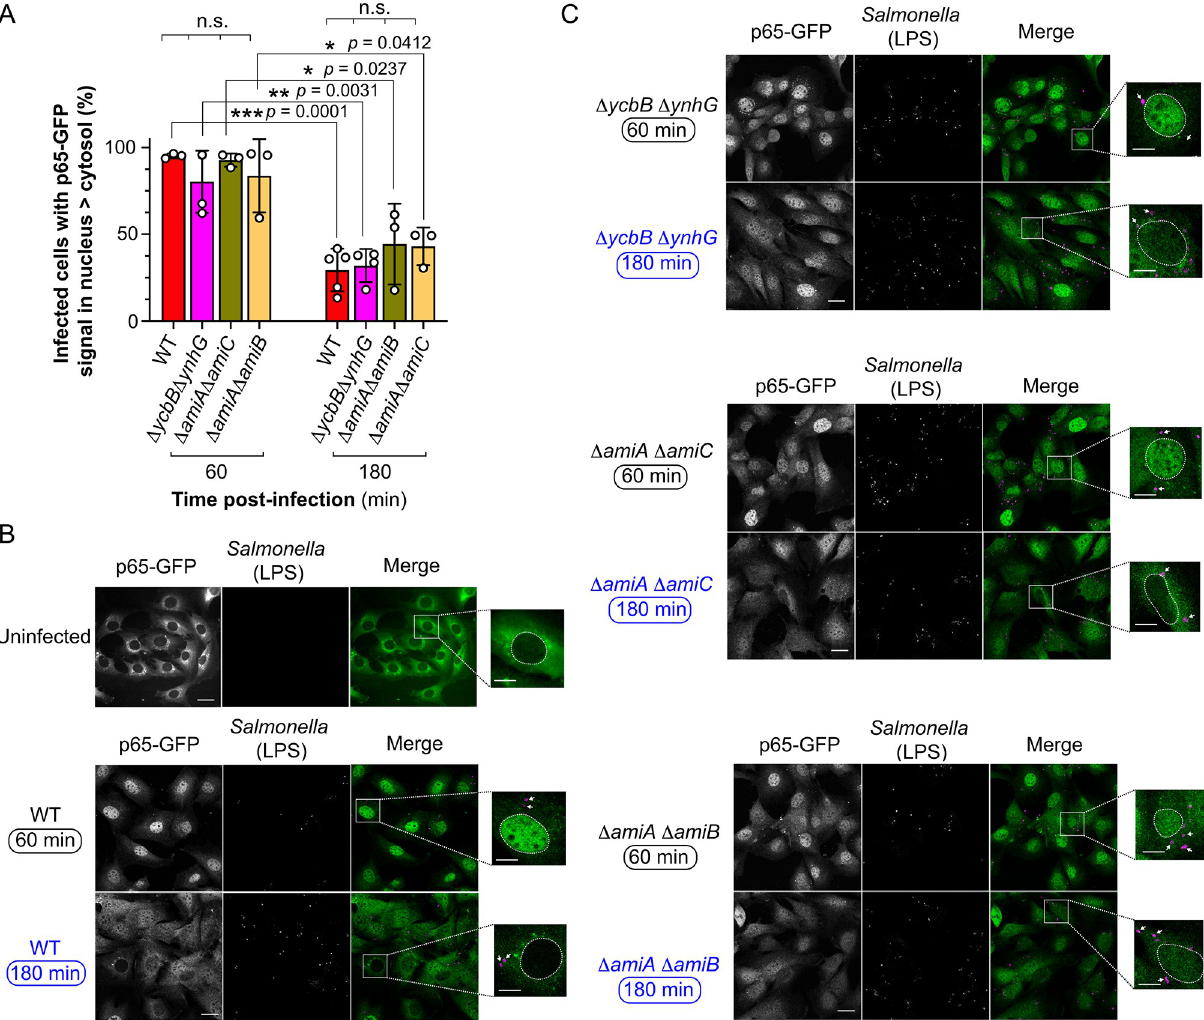
Fig 6. The deficiency in enzymes candidates to generate ISM-1, ISM-2 and ISM-4 does not impair intracellular S . Typhimurium for attenuating the NF- κ B response. (A) Percentage of infected fibroblasts having higher fluorescence signal in the nucleus derived from the p65-GFP reporter. Data are shown for two infection times (60, 180 min) and wild type and the indicated double mutants. � , P = 0.01 to 0.05; �� , P = 0.001 to 0.01; ��� , P = 0.0001 to 0.001. Unpaired Student t test for comparison of same strain in two different post-infection times and one way ANOVA with multiple comparisons of strains at the same post-infection time. Data from independent replicates are shown by circles and bars represent the mean and standard deviation values. (B) Mouse reporter fibroblasts expressing p65-GFP uninfected or infected with wild type S . Typhimurium at two post-infection times, 60 and 180 min. Representative images of p65-GFP signal (green) and Salmonella stained with anti-LPS antibodies (magenta). Images on the right are enlargements of individual uninfected or infected cells. Arrows point to intracellular bacteria. Bars, 25 μ m (left) and 10 μ m (enlargements). (C) Same as in wild type bacteria but for the indicated double